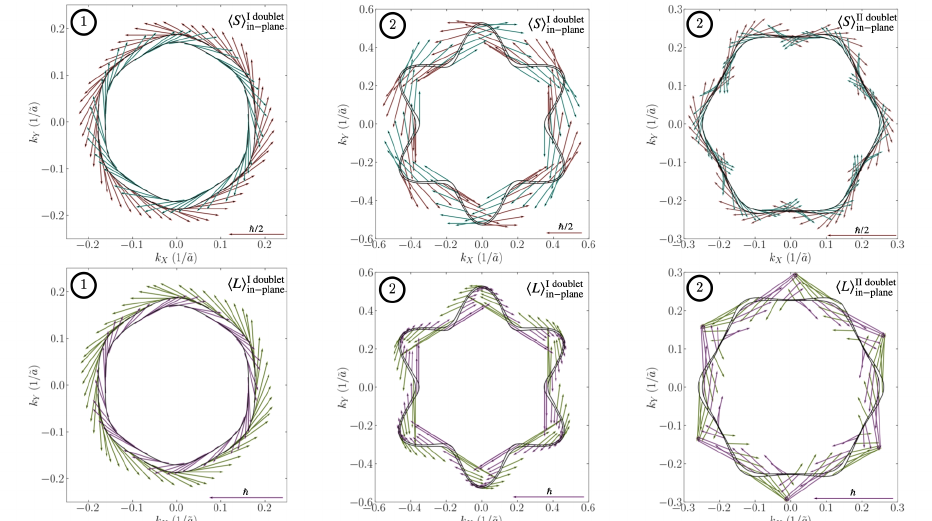
Figure A1. In-plane spin ( upper panel ) and orbital angular momentum ( lower panel ) textures for the first and the second doublet with the chemical potential fixed to the value corresponding to the benchmark lines 1 and 2 in Figure 1. The red and green arrows represent the mean value of the in-plane component of the operator for the external band, and the blue and pink refer to the internal component. The mean value of the generic operator O is evaluated as (cid:104) O (cid:105) =